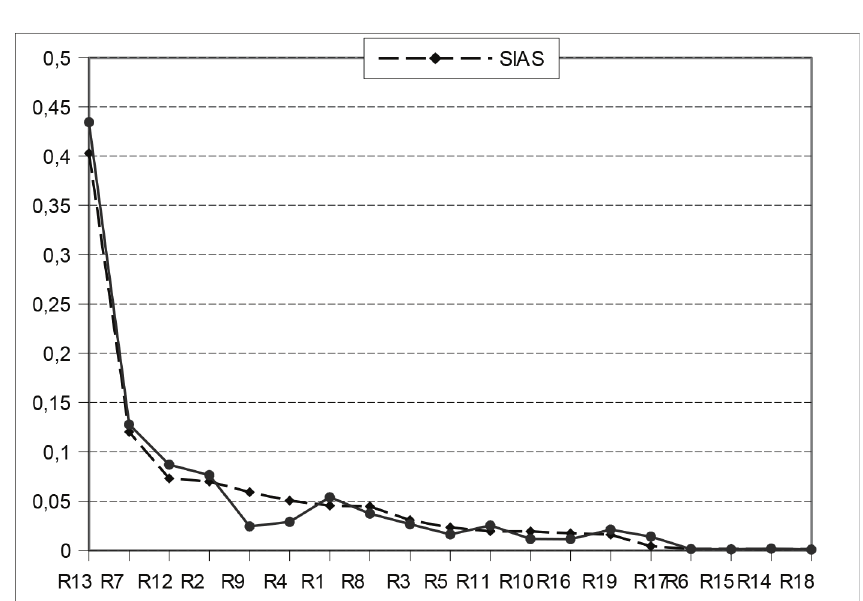
Figure 3 - Services Subsector (SS) vs SIAS Polygonal